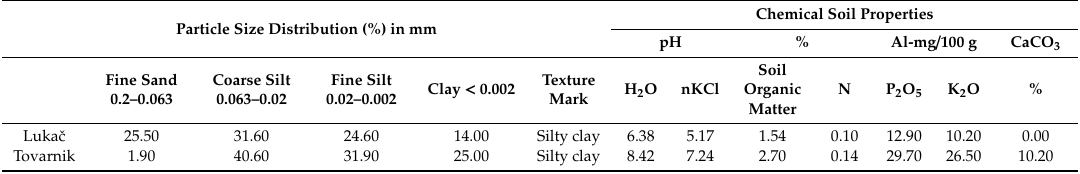
Table 2. Physical and chemical soil properties in Lukaˇc and Tovarnik, 2016.